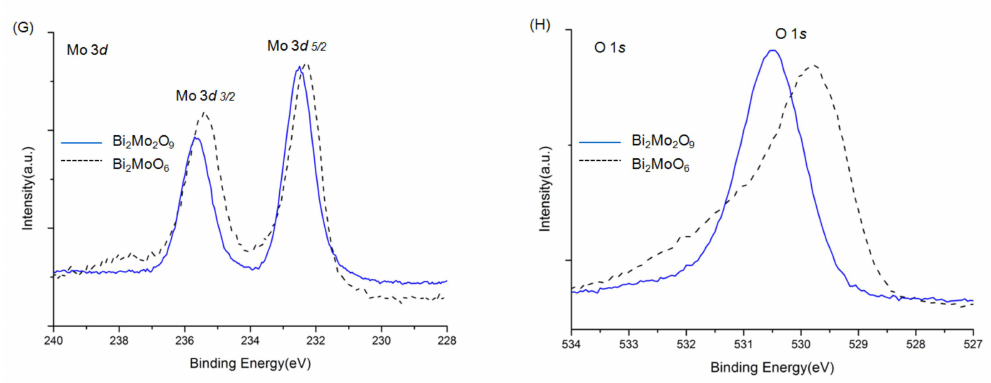
Figure 5. XPS spectra of Bi 2 WO 6, Bi 2 W 2 O 9 , Bi 2 MoO 6 and Bi 2 Mo 2 O 9 : (( A ): Bi 2 WO 6 and Bi 2 W 2 O 9 ) (( E ): Bi 2 W 2 O 9 ) overall spectra; ( B , F ) Bi 4 f ; ( C ) W f ; ( D , H ) O 1 s ; ( G ) Mo 3 d